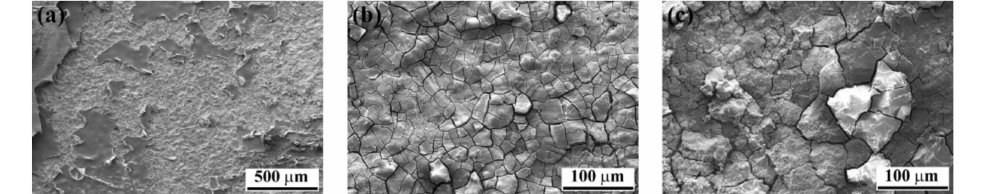
Figure 17. SEM images of the fracture surface of the SB specimen on the aluminum side after 12 months of outdoor weathering. ( a ) TZ from the area (1) in Figure 16c; ( b ) high-magnification image from the area (2) in Figure 16c, and ( c ) high-magnification image from the area (3) in Figure